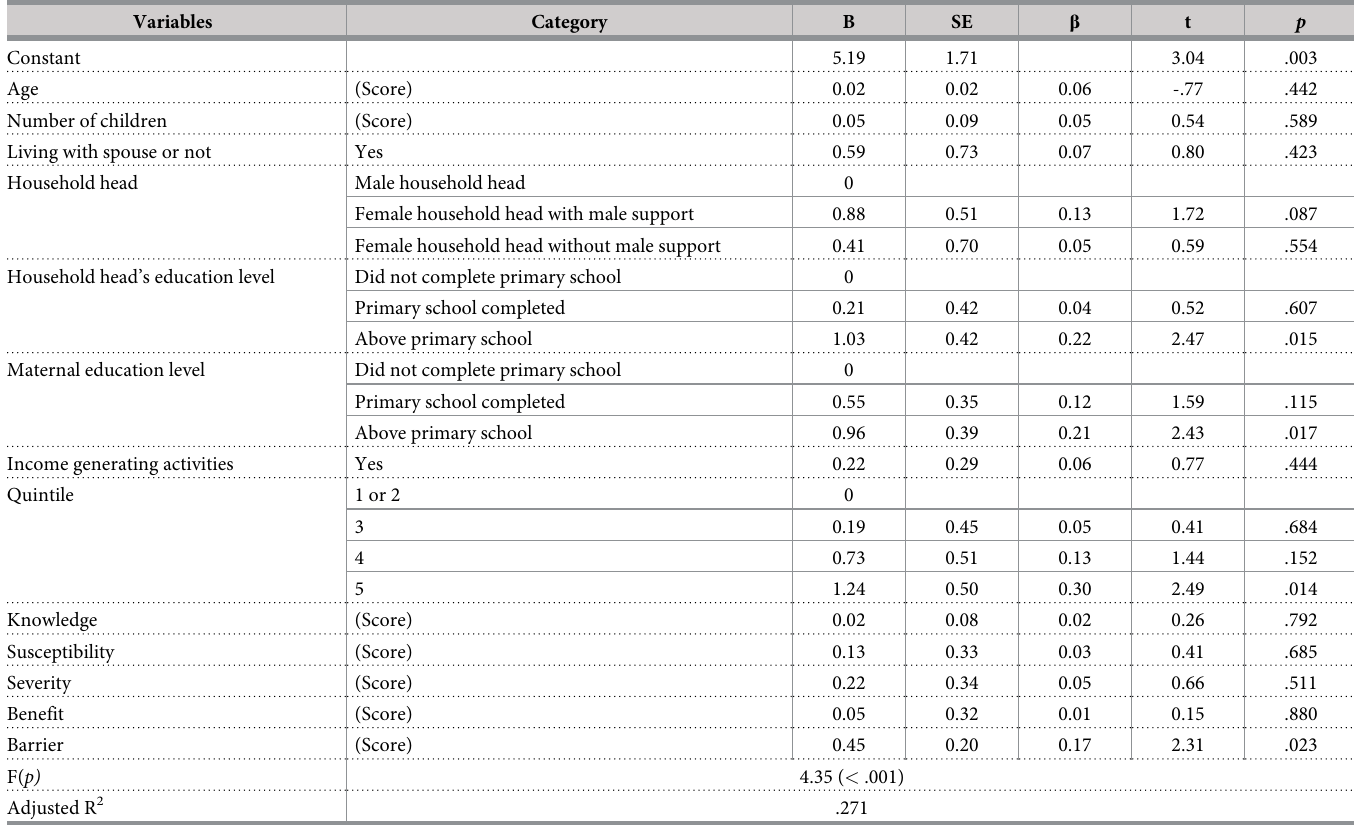
Table 5. Factors influencing nutritional practices.